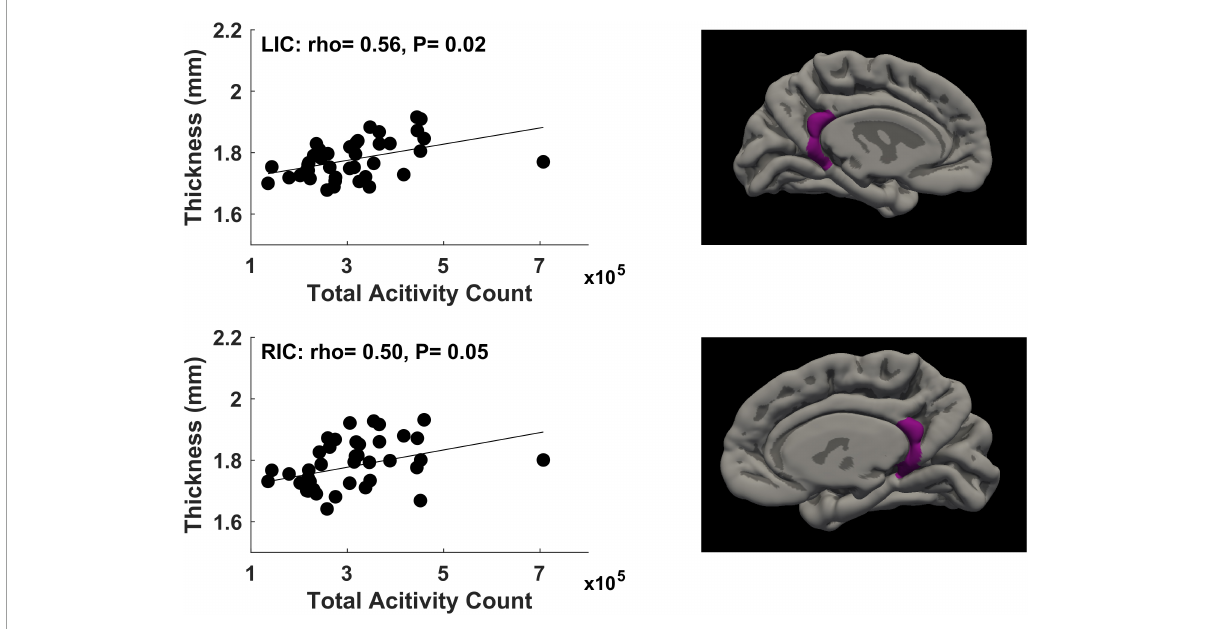
FIGURE3 Significant positive correlations ( P ≤ 0.05, FDR corrected) between mother’s physical activity at ∼ 24 weeks of pregnancy and newborn’s brain cortical thickness in the left isthmus cingulate (LIC) gyrus and right isthmus cingulate (RIC)